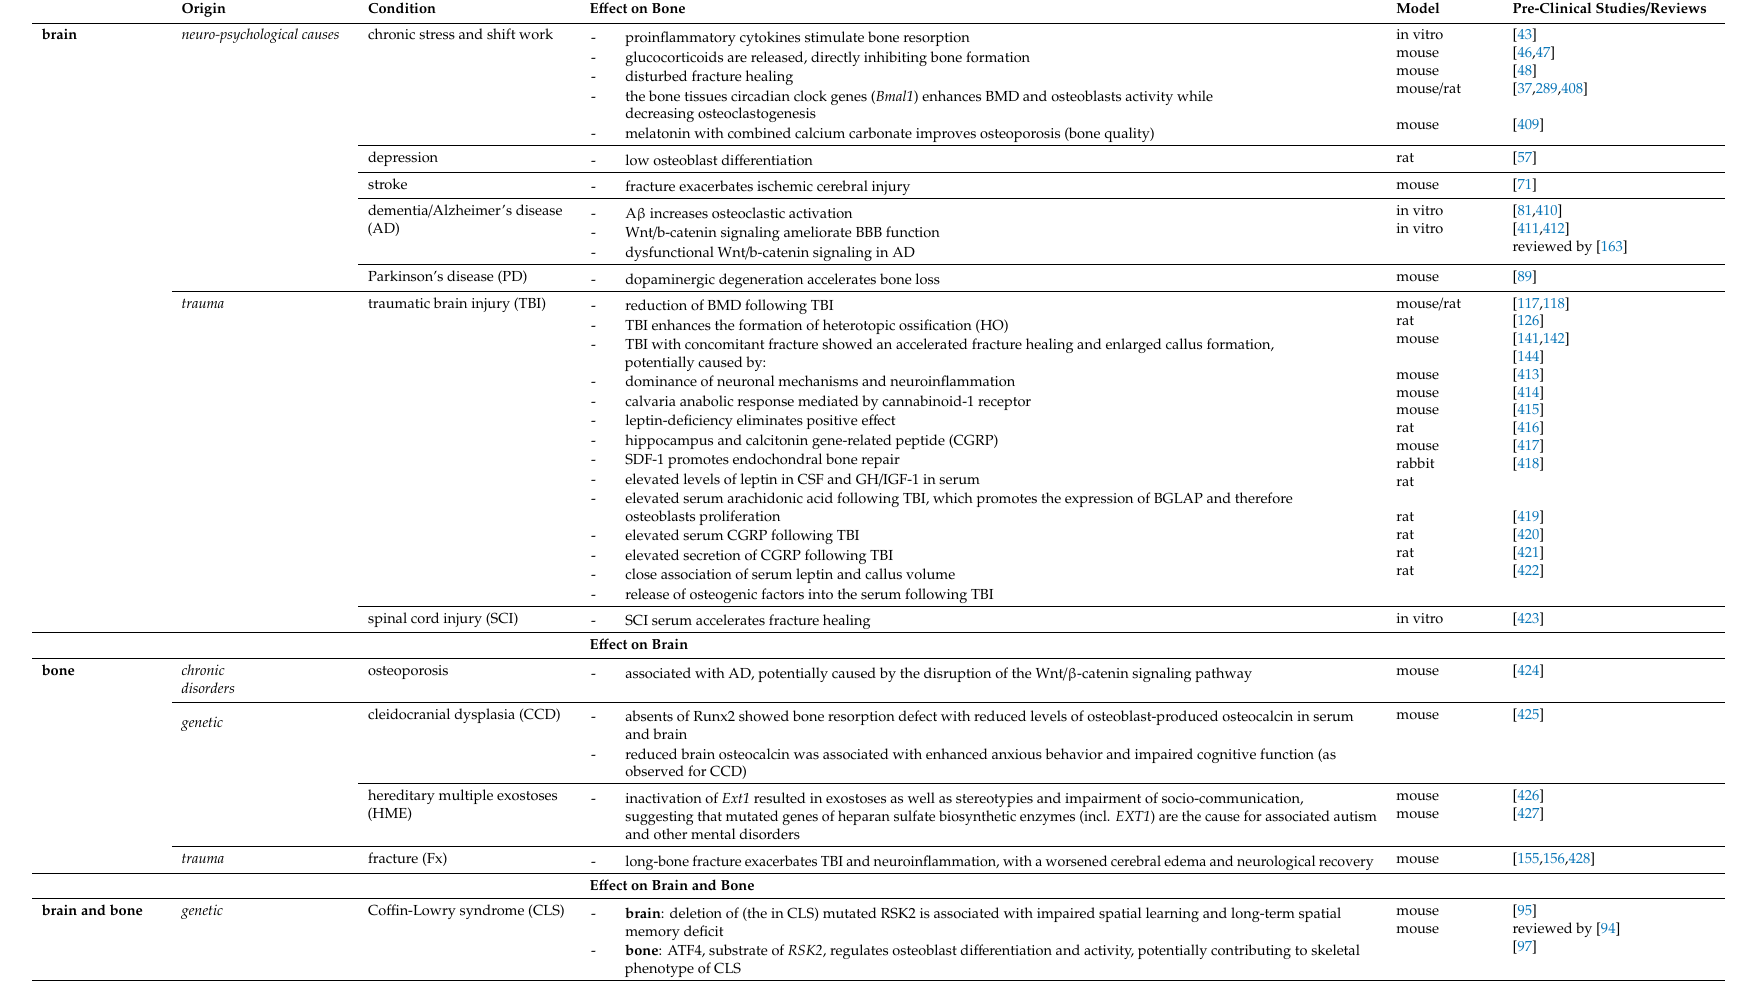
Table 2. Crosstalk of brain and bone: experimental observations.